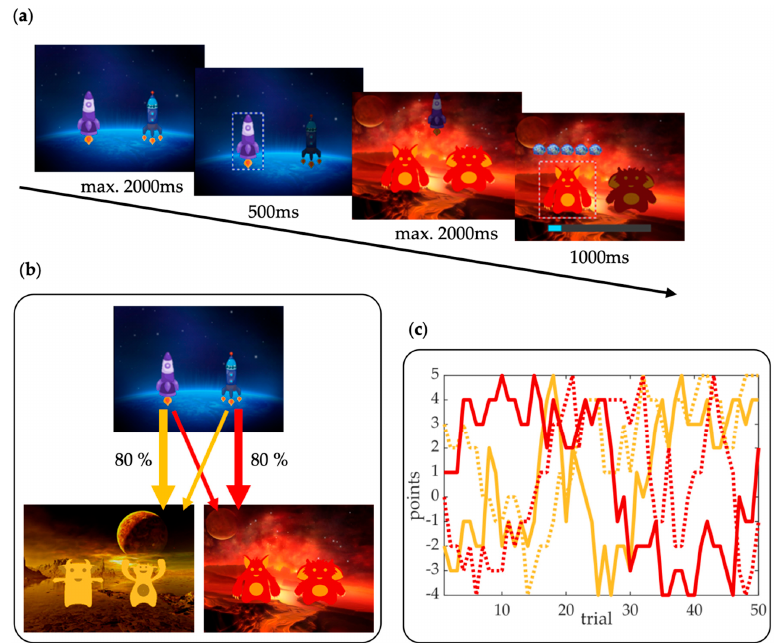
Figure 1. Two-step decision-making task. ( a ) An exemplary trial sequence as well as the trial timing are depicted: At the first stage, two spaceships were presented. Participants indicated their response choice via a button press, followed by a transition two the second stage. Two aliens represented second-stage choice options and participants made their second response choice via another button press. Response choices were indicated by boxes around the respective spaceship/alien and trial outcomes are indicated by blue spheres (space treasure) representing the number of gained points (+5 shown) or pink spheres (antimatter) representing the number of lost points (not shown). The response time limit was 2 s for each of the two choices. According to the transition structure ( b ), a transition could either be common (80% probability) or rare (20% probability). After the second stage response, the outcome was presented. ( c ) The outcomes (+5 to − 4 points) of the four choice options are presented for the first 50 trials. Each line represents a second-stage choice option (alien) for the yellow and red planet, respectively. The dual-system reinforcement-learning model is an established computational model for the task we used. It assumes a mixture of model-based and model-free learning strategies [27,28]: During the course of the task, expected values (Q-values) will be learned for each choice option ( a ) in each state ( s ) at the two stages ( i ). The model-free value ( Q MF ) is updated at each trial ( t ) according to a state-action-reward-state-action, or SARSA( λ ) temporal difference learning algorithm [27,51]. After each action, an update takes place to calculate a new estimate of the value of the chosen option based on the agent’s experience. The general updating rule is: